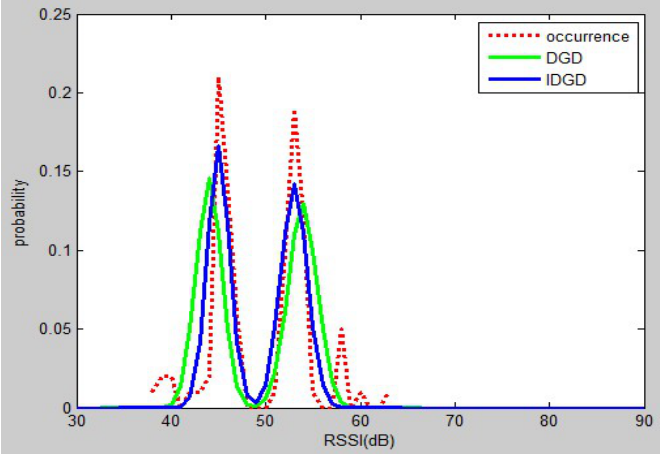
Figure 3. Comparison of DGD and IDGD with the empirical distribution of